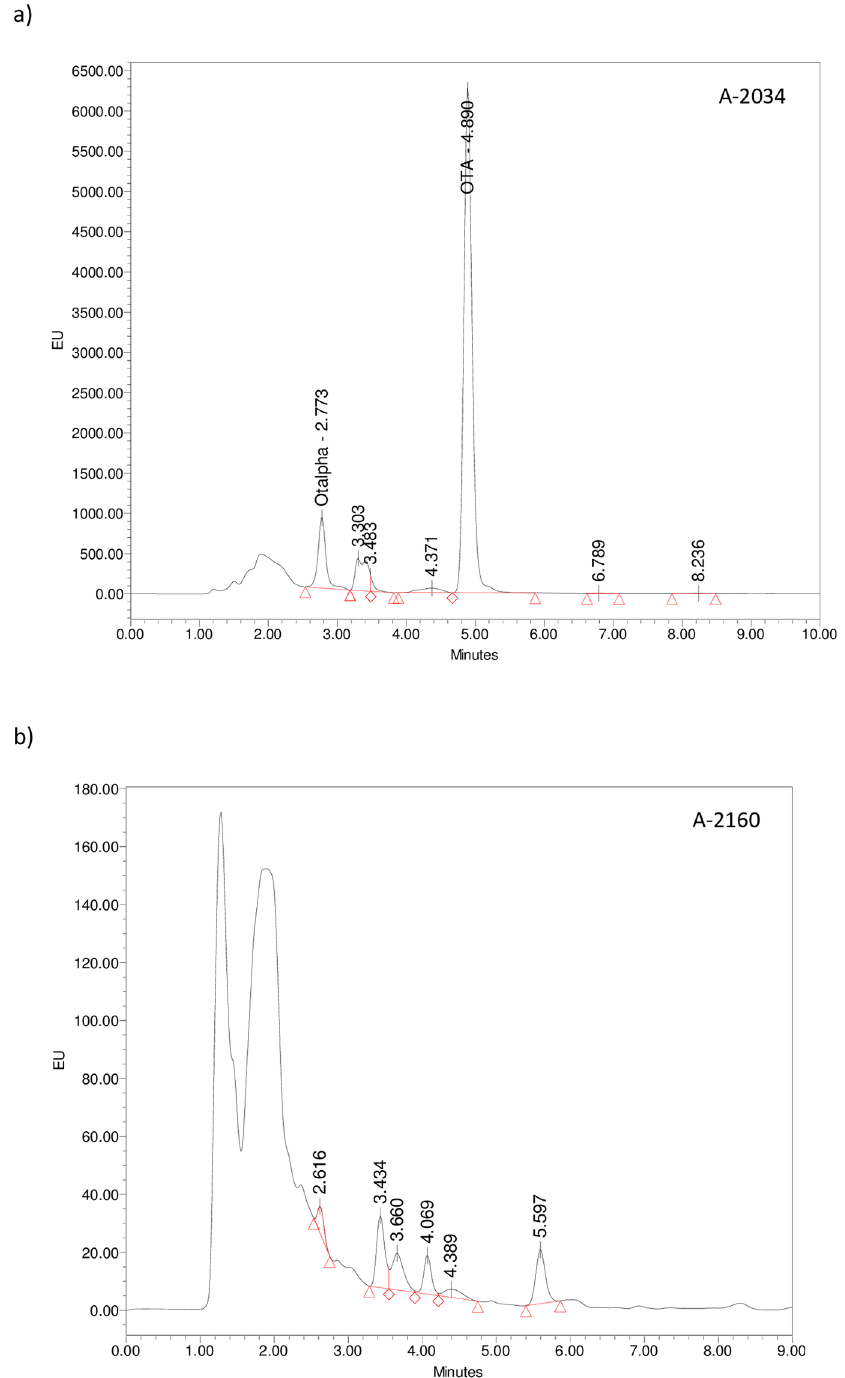
Fig 1. Selected chromatograms of fungal extracts analysed using HPLC coupled to a fluorescence detector of (a) an OTA/OT α -producing strain ( A . carbonarius A-2034) (OT α retention time: 2.773 min; OTA retention time: 4.890 min) and (b) a non-OTA/OT α -producing strain of ( A . carbonarius A-2160), after incubation at 15˚C for 30 days on Czapek Yeast extract Agar.